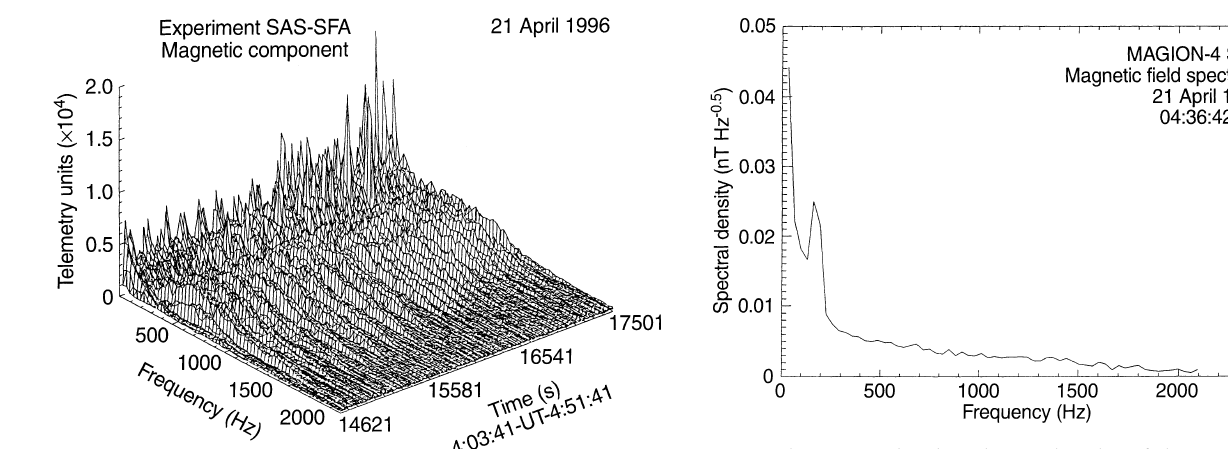
Fig. 8. The same as in Fig. 7 but at the edge of the entry layer or